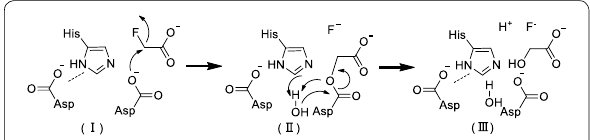
Fig. 1 Proposed two‑step reaction mechanism of fluoroacetate